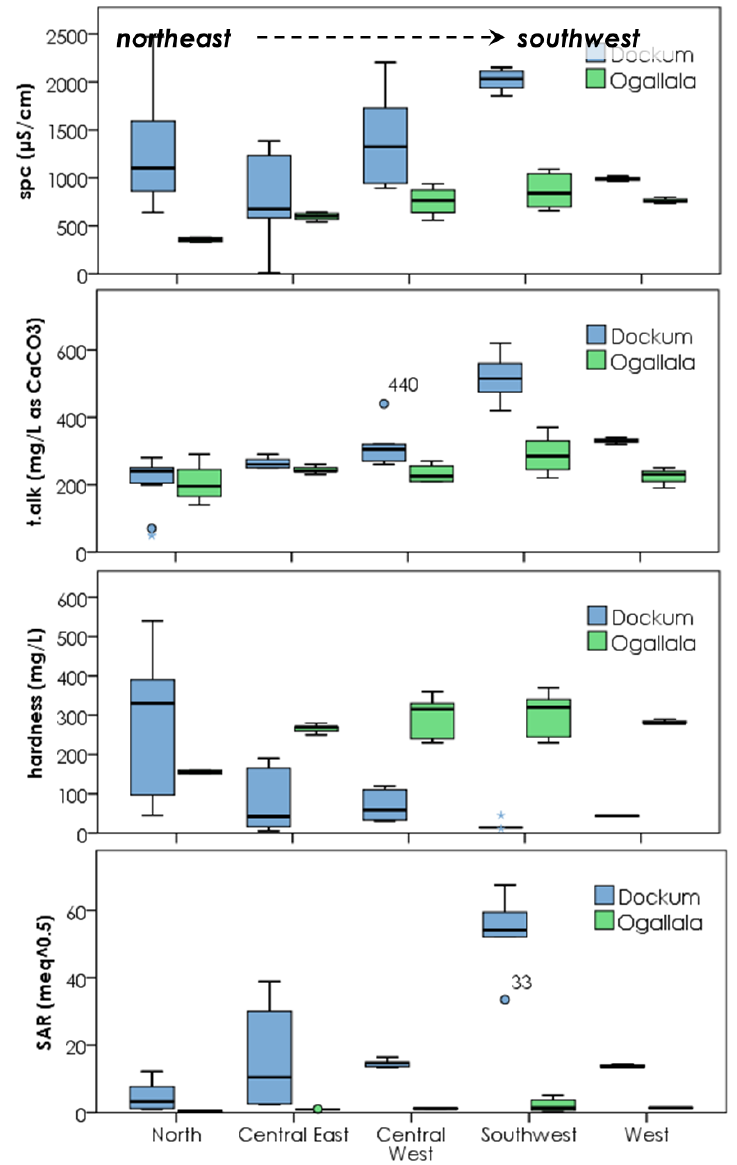
Figure 8. Spatial group comparison divided by aquifer within each group. Box plots indicate all of the samples collected over the entire sampling period for all wells within the aquifer-group class. The number of samples per plot ranges from 3 to 12 for 81 samples in total.